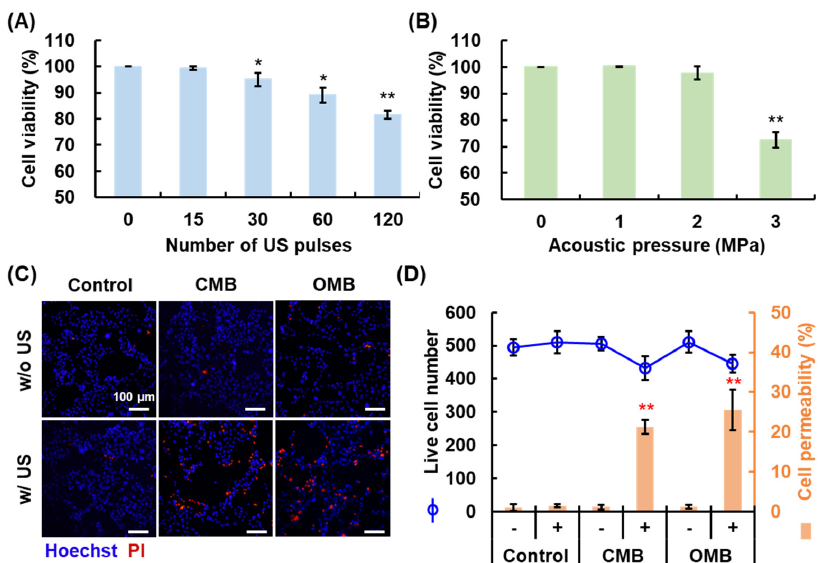
Figure 5. Evaluation of optimal HIFU parameters for cell sonication by cell viability under the various ( A ) number of US pulses and ( B ) acoustic pressures (* p < 0.05, ** p < 0.01). ( C ) The correlation between cell viability and permeability enhancement by OMB treatment. The fluorescence images show live cells in blue (Hoechst 33342) and permeability-enhanced cells in red (PI). ( D ) Corresponding quantification data of live cell number and the percentage of permeable cells (** p <